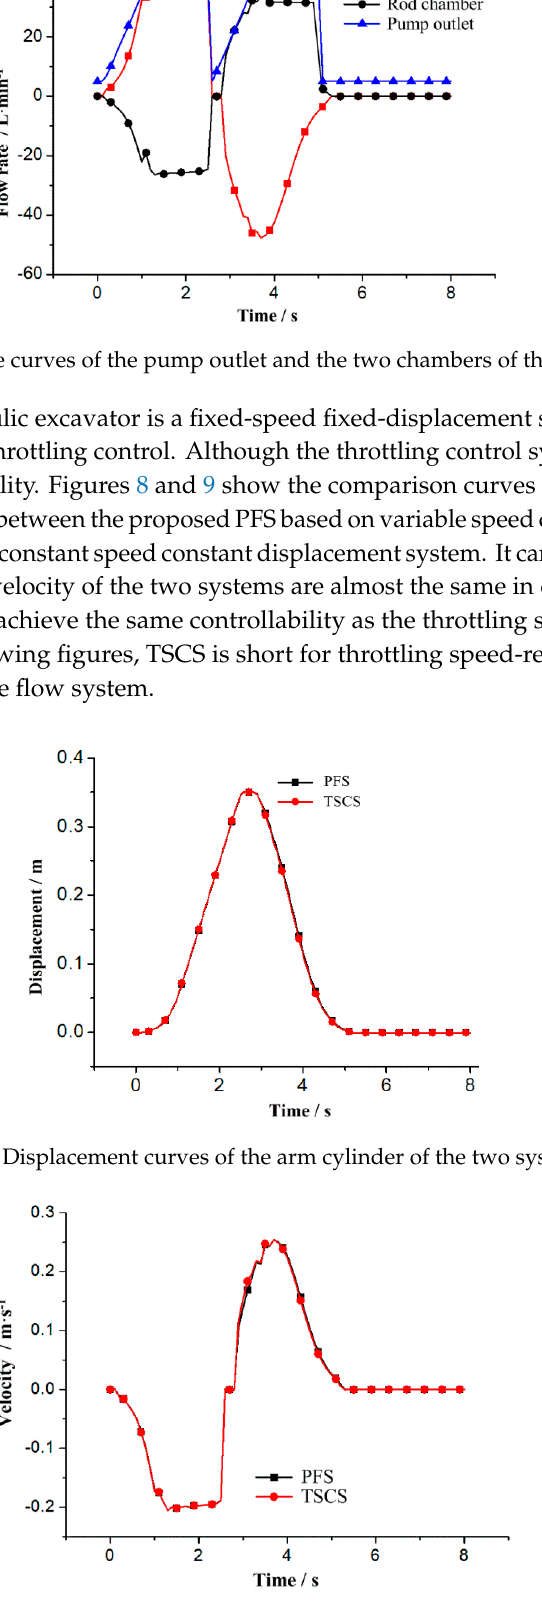
Figure 9. Velocity curves of the arm cylinder of the two systems.